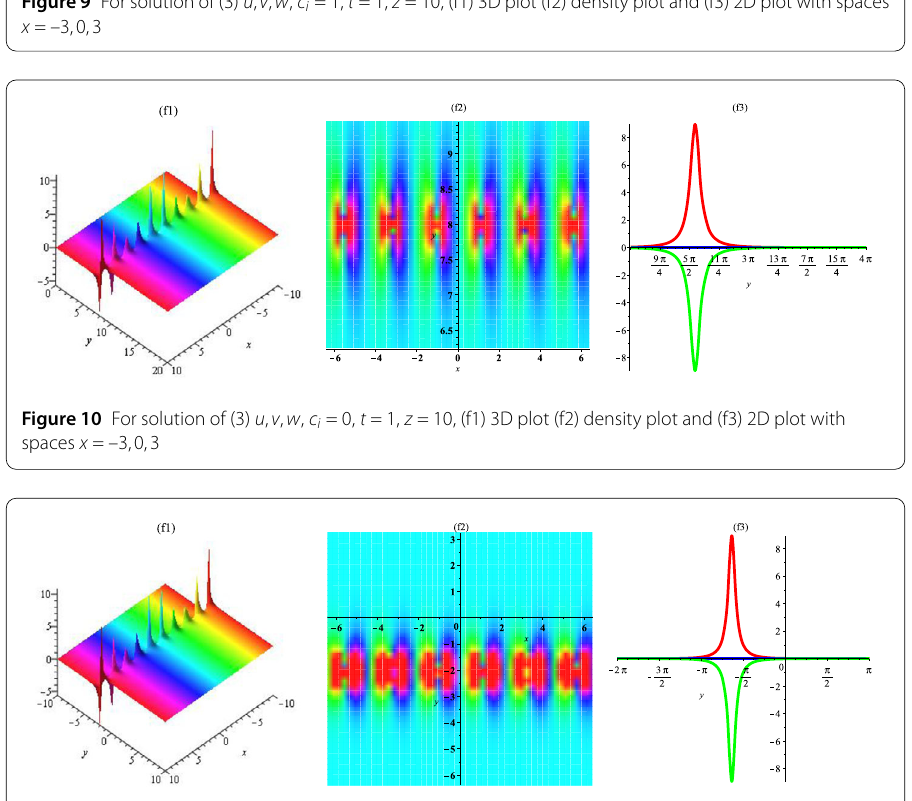
Figure 11 For solution of (3) u , v , w , c i = 0, t = 1, z = 10, (f1) 3D plot (f2) density plot and (f3) 2D plot with spaces x =